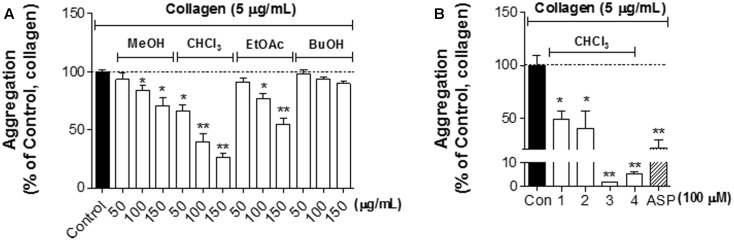
The effect of crude extracts and constituted compounds from Lindera obtusiloba on collagen-induced platelet aggregation. (A,B) Washed rabbit platelets in CaCl2 (1 mM) were pre-incubated for 3 min with L. obtusiloba extracts (MeOH, CHCl3, EtOAc, and BuOH) (50–150 mg/mL) (A) or isolated compounds (1–4, 100 μM) and aspirin (ASP) (B). Then the cells were stimulated with collagen (5 μg/ml) for 5 min and platelet aggregation was assayed. Data are expressed as the means ± SEM (n = 3). ∗p < 0.05, ∗∗p < 0.01 vs. control (Con, collagen treatment, but no experimental materials).